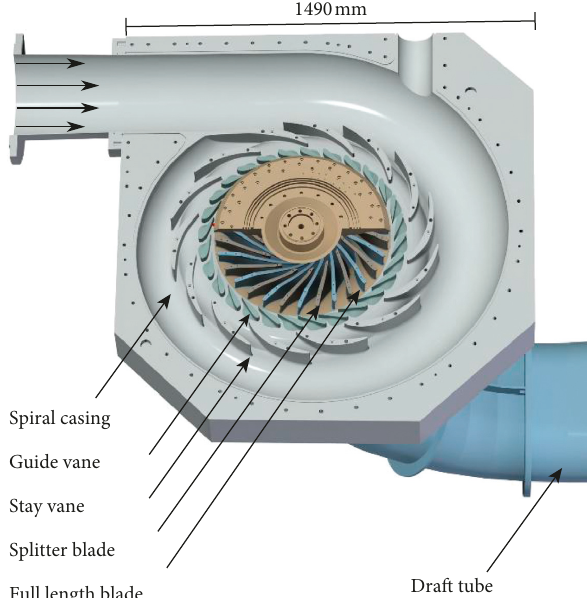
Figure 4: Three-dimensional view of the investigated Francis turbine.